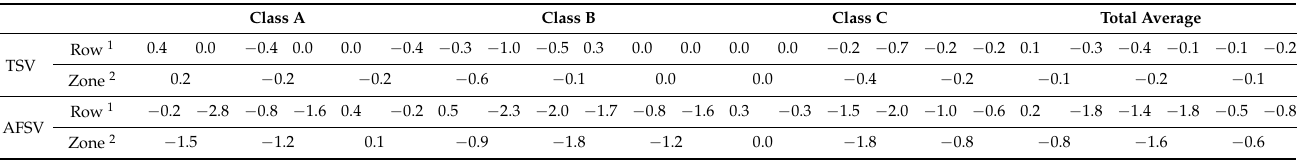
Table 7. TSV and AFSV average per row and